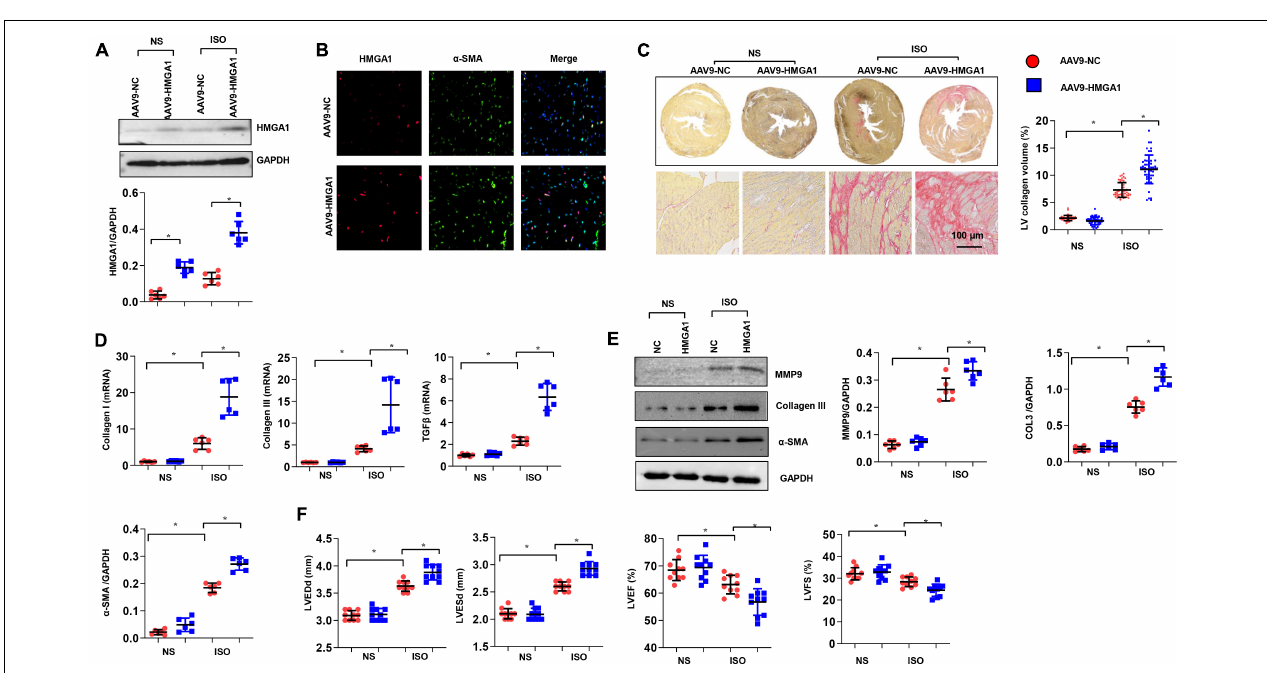
FIGURE 2 | High-mobility group A1 (HMGA1) overexpression aggregated cardiac fibroblast activation in vitro . (A) The protein level of HMGA1 in fibroblasts transfected with ad-HMGA1 ( n = 6). (B–D) Cardiac fibroblasts (CFs) were transfected with ad-HMGA1 and stimulated with TGF β 1 for 24 h. (B) Cell proliferation detected by cell counting kit 8 (CCK8) assay ( n = 6). (C) Immunofluorescence staining of PCNA ( n = 5). (D) Immunofluorescence staining of α -SMA ( n = 5). (E) Transcription levels of collagen I, collagen III, and connective transforming tissue factor (CTGF) ( n = 6). * p < 0.05.